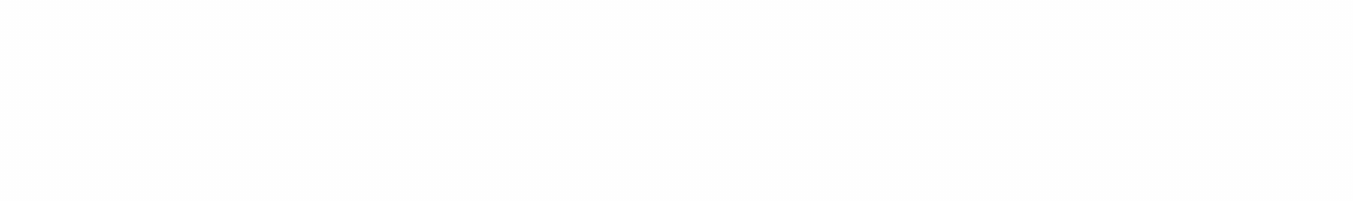
Table III, observes the following rules: first, a